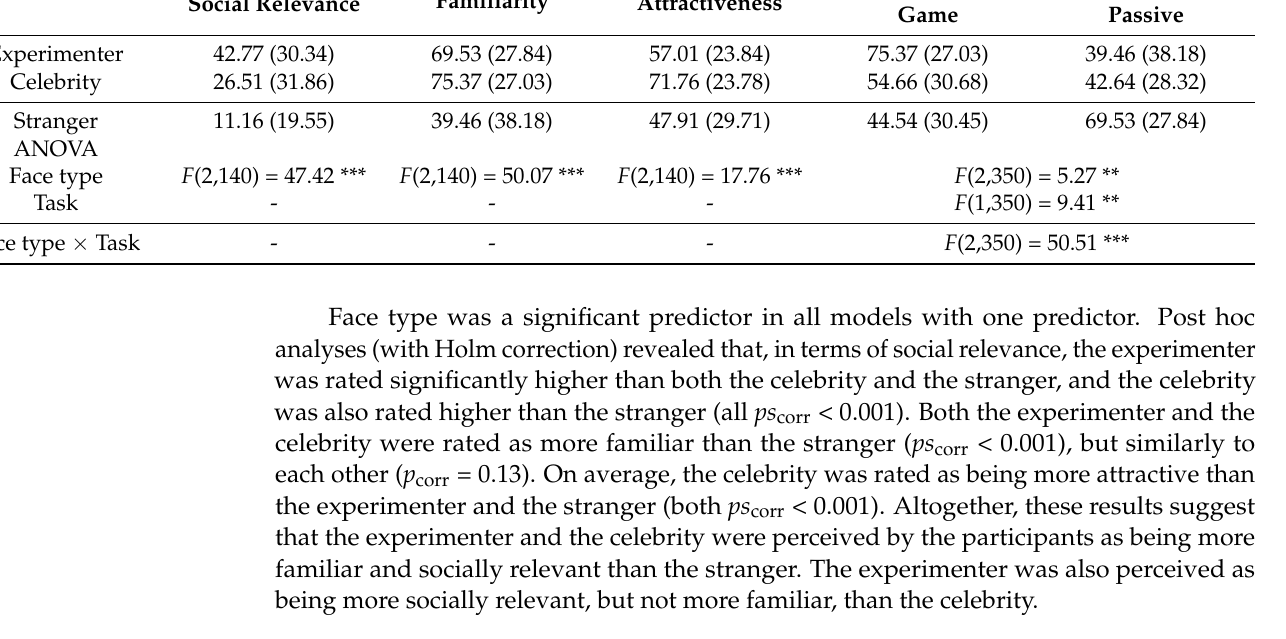
Table 1. Mean subjective ratings (and standard deviation) of social relevance, familiarity, attractiveness, and reward value for each type of face (experimenter, celebrity, stranger). p -values < 0.01, <0.001 are marked with **, and ***, respectively. Social Relevance Familiarity Attractiveness Experimenter Celebrity ANOVA Face type Task Face type ×